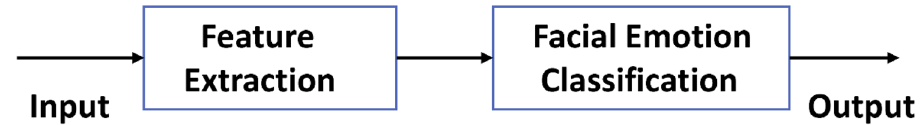
Figure 1. A simple structural view of facial expression recognition